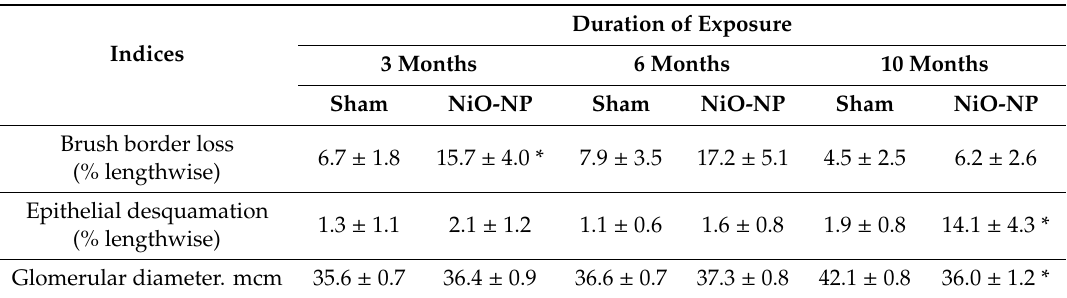
Table 8. Morphometric indices for the state of rat kidneys after inhalation exposure to NiO-NPs at a 0.23 ± 0.01 mg / m 3 concentration for 3, 6, or 10 months; mean results for at least 3 rats in exposed and